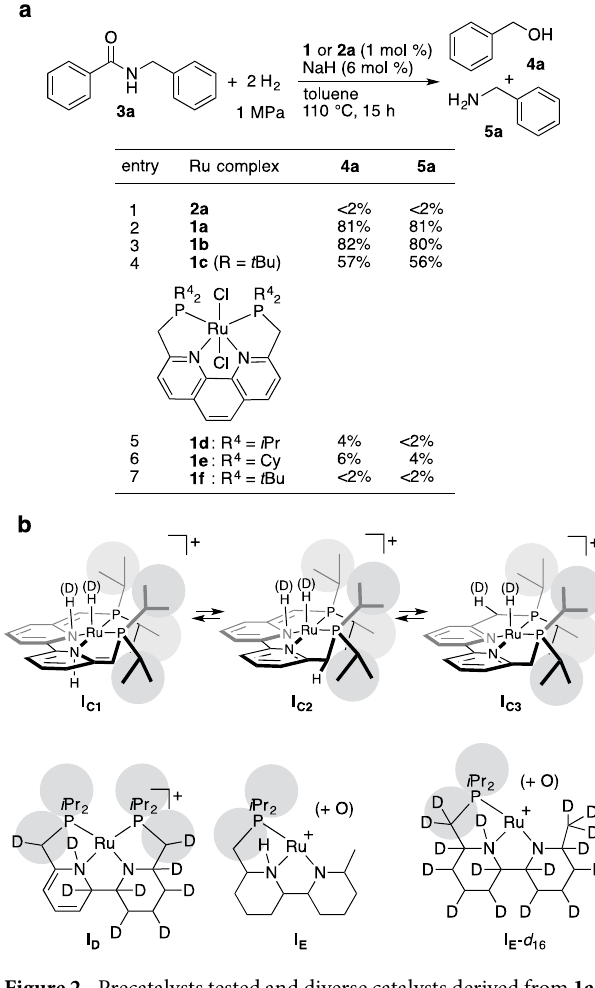
Figure 2. Precatalysts tested and diverse catalysts derived from 1a . ( a ) Hydrogenation of 3a using different Ru- complexes 1a – f and 2a ([Ru] 0 = 3.3 mM) as precatalysts. ( b ) Major resting states of catalysts. Calculated exact masses: I C1 – I C3 (519.1626), I C - d 2 (521.1752), I D (534.2661), I E (429.1603) and I E - d 16